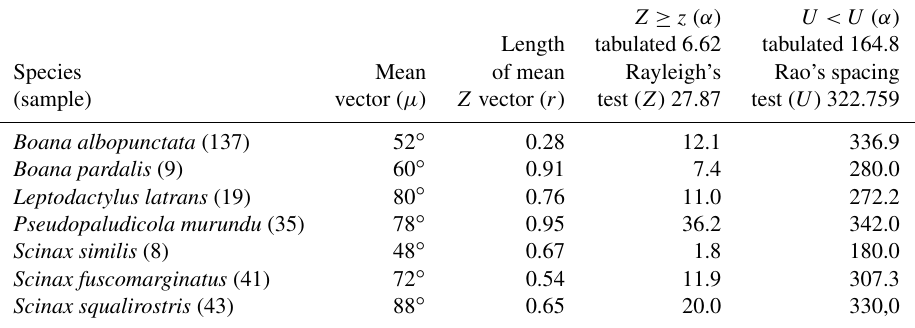
Table 4. Species with non-random unidirectional behavior in quadrant II of the polar axis (46–134 ◦ ) clockwise, under the influence of the synodic cycle between the waning crescent and waxing gibbous (intermediate albedo); n − 1 degrees of freedom and p = 0 . 01.